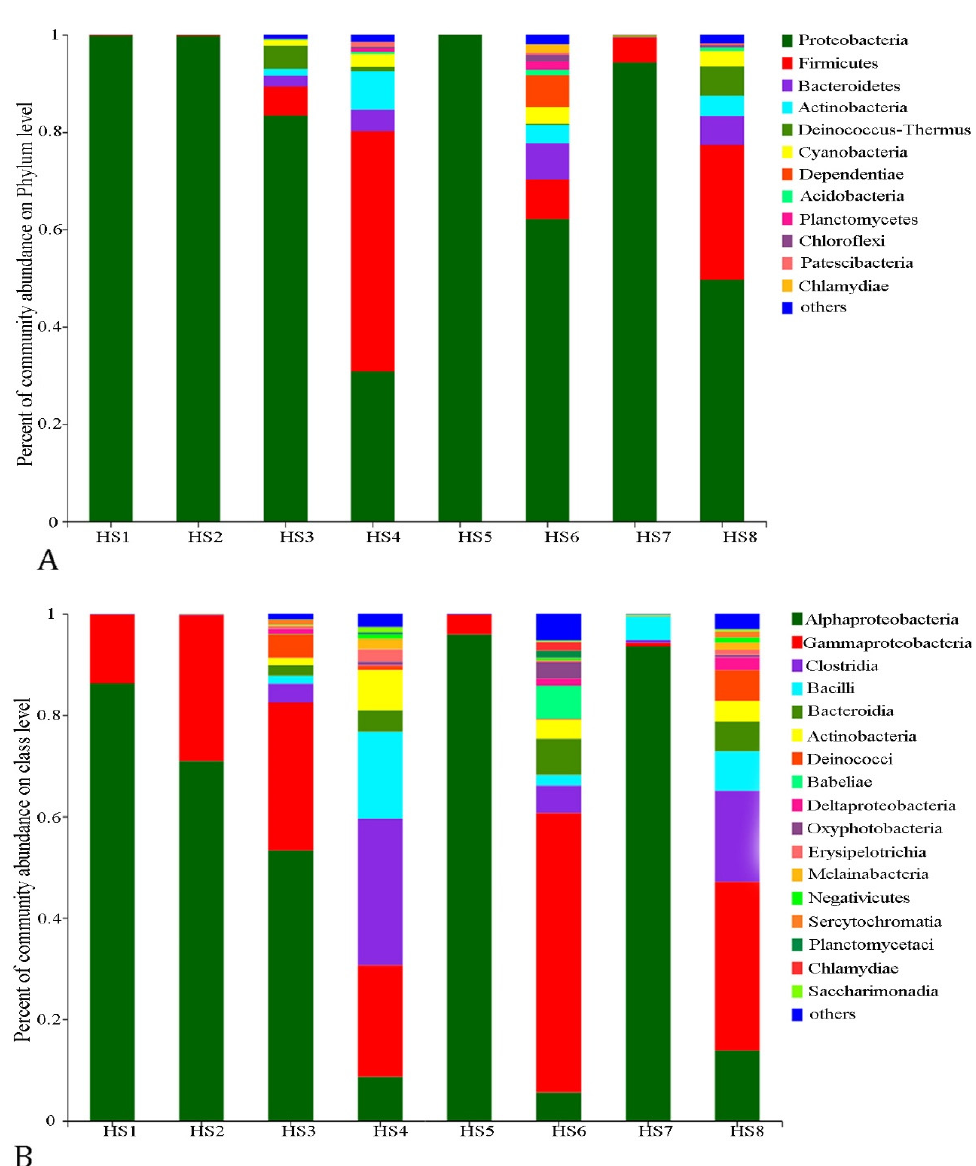
Figure 2. Bacterial composition of different sampling sites from the Huangshui River, the ecotone zone of Qinghai Plateau and Loess Plateau, China. ( A ) The relative abundance of the dominant bacterial phylum and ( B ) relative abundance of the dominant bacterial class are shown in a stack plot. The relative abundances are based on the ≥ 97% similarity clusters of the OTUs.